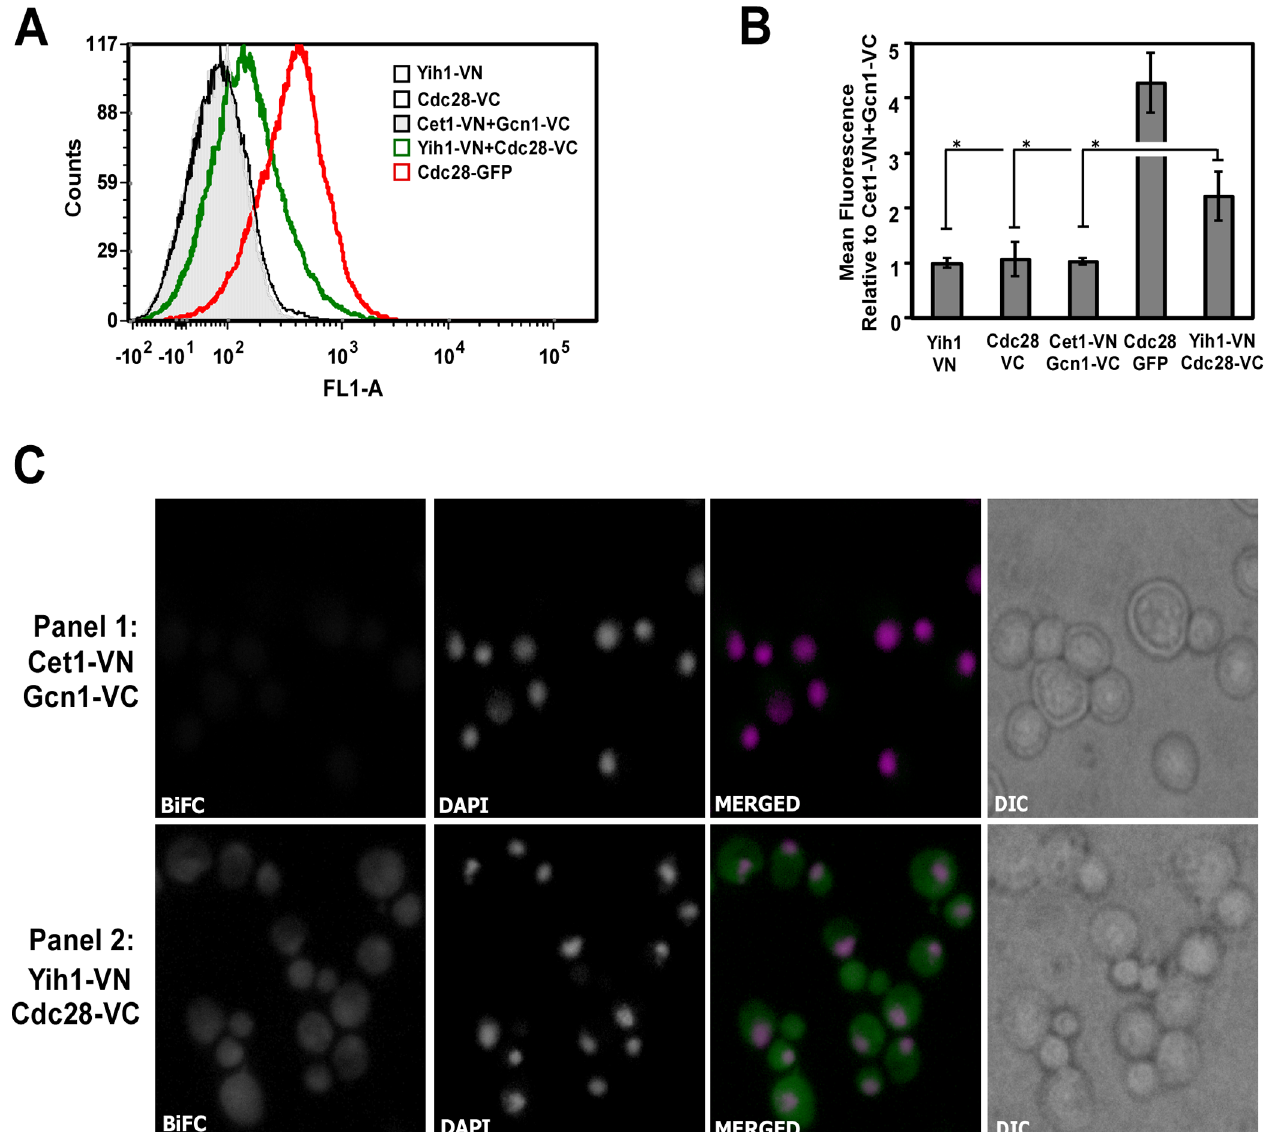
Fig 7. Endogenous Yih1 physically interacts with Cdc28. Visualization of Yih1-Cdc28 interaction by BiFC analysis. (A) Representative flow cytometry histograms of live cells grown in SD medium to log phase. 2x10 4 cells were analyzed per acquisition using the FL1-A channel. The strain co-expressing the protein Cet1 tagged with VN and the protein Gcn1 tagged with VC (Cet1-VN+Gcn1-VC) was used to define the basal fluorescence signal (gray filled histogram). The strain co-expressing Yih1-VN and Cdc28-VC (BCY20) showed increased signal intensity, indicative of a positive BiFC signal (green unfilled histogram). Strains expressing Yih1-VN (VN_3198) or Cdc28-VC (BCY21) alone were negative (black unfilled histograms). A strain expressing Cdc28 fused to GFP (YBL160W) was used as a positive control (red unfilled histogram). (B) The mean fluorescence intensities of each cell population analyzed in (A) were determined using the FlowJo software, version 9.3.3. The bar graph shows the mean fluorescence intensities of the analyzed strains relative to the values measured in the strain Cet1-VN+Gcn1-VC, which was set to 1. Data represent mean ± SE as error bars of three independent experiments performed in duplicate. * p < 0.05; (Student´s t test). (C) Representative fluorescence images of live cells grown as in (A). The strain co-expressing Cet1-VN+Gcn1-VC (RRY62a) is shown in panel 1. The strain co-expressing Yih1-VN and Cdc28-VC (BCY20) is shown in panel 2. In the merged images, nuclear DNA staining with DAPI is shown in magenta, the BiFC signal is shown in green, and the colocalization of DNA with the BiFC signal from Yih1-Cdc28 is shown in white, using the software Image J. DIC is also displayed. Images for strains expressing Yih1 (VN_3198) or Cdc28 (BCY21) alone are provided in S2